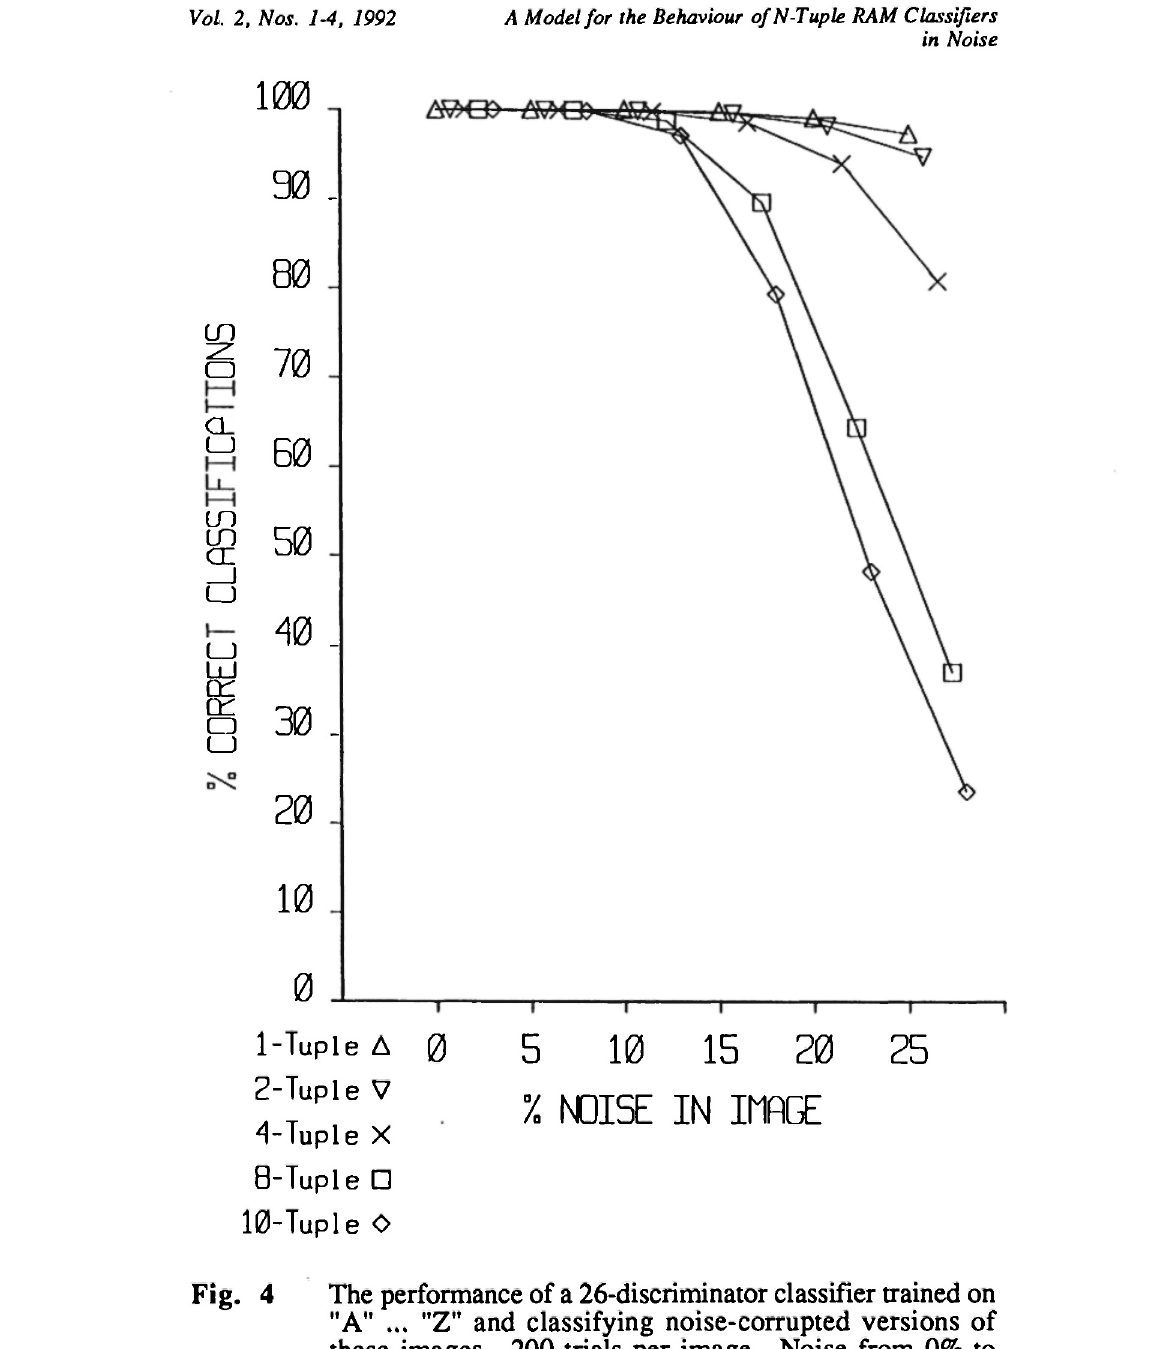
Fig. 4 The performance of a 26-discriminator classifier trained on "A" ... "Z" and classifying noise-corrupted versions of these images. 200 trials per image. Noise from 0% to 25% in 5% increments. Note that the abscissas of the values for 2 ... 10-tuples are offset relative to their true positions to improve